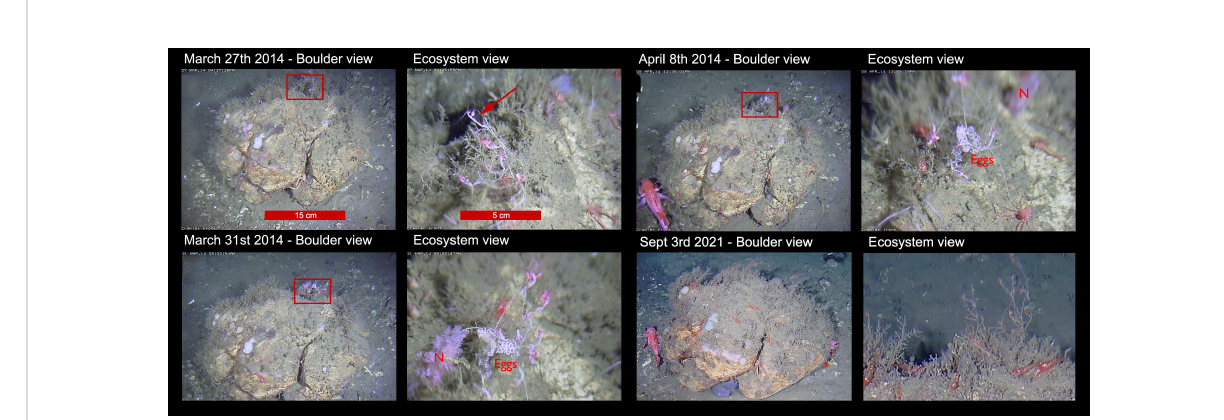
FIGURE 3 Boulder providing several niches colonized by galatheids, rock fi sh and harpacticoids, and the short (i.e., weeks) and long (i.e., years) term evolution of this small ecosystem. Two images (i.e., a view of the entire boulder -letters a, c, e, and g- and a zoomed part de fi ned by a red rectangle -letters b, d, f, and h-) are provided for each observation. The red arrow points towards a harpacticoid shrimp on top of biogenic (bryozoan) substrate, while the red “ N ” indicates a